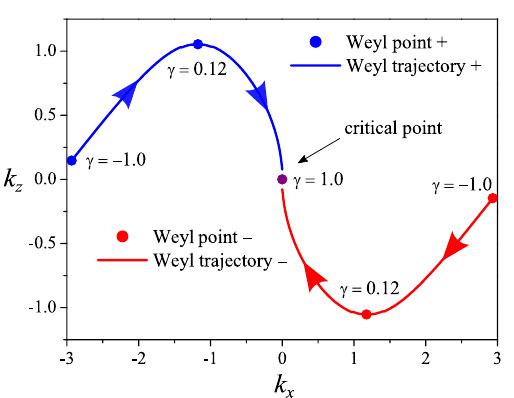
Figure 4. Schematic representation of the zero-energy Fermi arcs. ( a ) Fermi arcs for the Weyl semimetal model Eq. (1), with Weyl point projections only in the planes k x Fermi arcs for the generalized model Eq. (9), where the Weyl point projections are now present in all planes in momentum space, including the projection along the plane k x additional term t a sin k z promotes a rotation of the Weyl point projection around the k y direction. This allows the calculation of the penetration depth also in the z direction in case ( b ). For simplicity, we show only the projections along the three independent planes 47,48 .